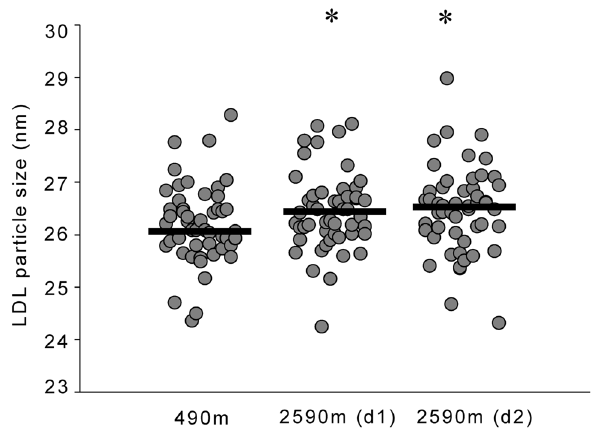
Figure 3. Effects of moderate altitude on LDL diameter. Scatterplot showing individual median low density lipoprotein (LDL) diameter in Zurich (490 m) and Davos Jakobshorn (2590 m) during day 1 and day 2. Black lines represent medians. LDL diameter was larger on both days at 2590 m compared to 490 m. *p , 0.05 vs 490 m.